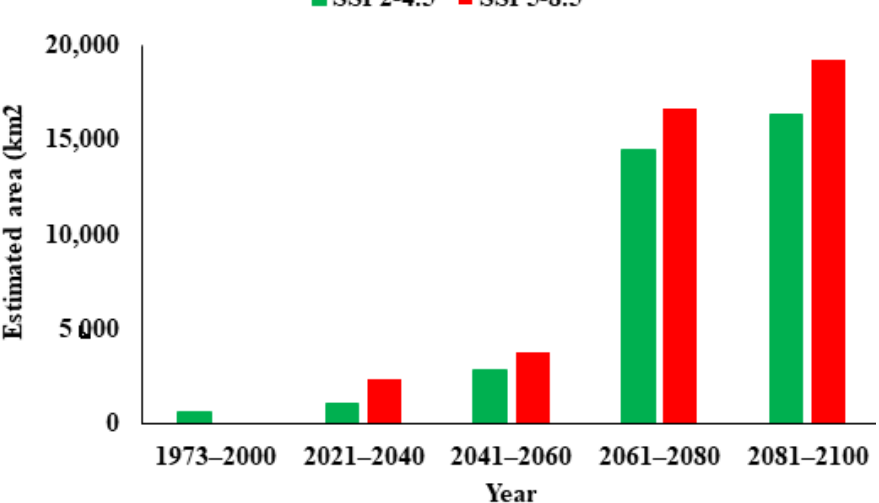
Figure 4. Potential habitat estimation of P. hysterophorus in South Korea under the current climate (1973–2000) and future climate scenarios (SSP2-4.5 and SSP5-8.5; 2021–2040, 2041–2060, 2061–2080, and 2081–2100). Green and red bars indicate SSP2-4.5 and SSP5-8.5, respectively. Next, we evaluated the habitat suitability for P . hysterophorus in the different ADs of South Korea. Table 5 shows the estimated area of P . hysterophorus under the current and future climate scenarios in 17 ADs. Currently, P . hysterophorus exists in six ADs, including South Jeolla, North Jeolla, South Chungcheong Gwangju, North Gyeongsang, and Daegue, with each AD estimated to be 18–220.5 km 2 (Table 5). However, the suitable habitats for P . hysterophorus would expand across the whole country by 2081–2100 in all ADs (except Incheon and Seoul, located in the northwestern part of the country) under SSP2-4.5 and